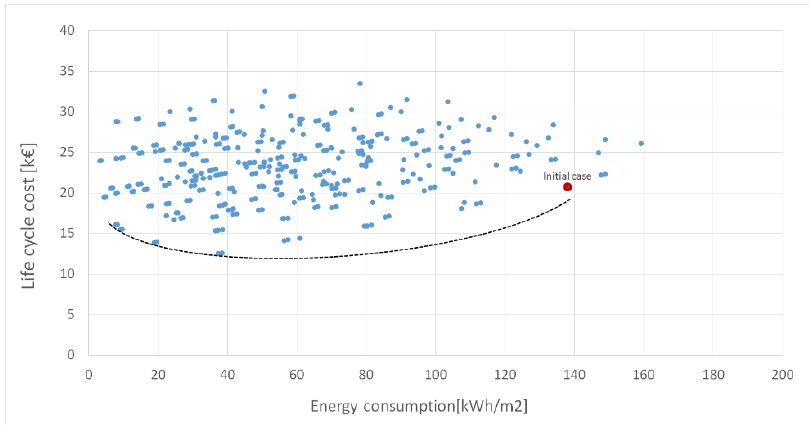
Figure 12. 30- year life cycle analysis [€] vs. heating and cooling demand (Wh). Figure 12. 30-year life cycle analysis [ € ] vs. heating and cooling demand (Wh).